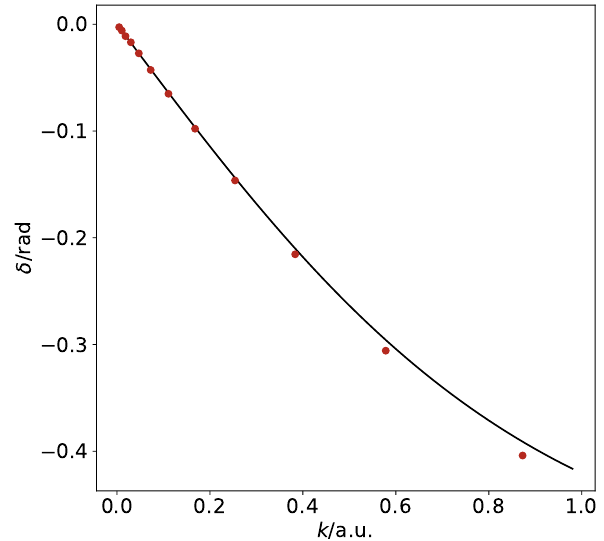
Figure 3. Positron–hydrogen s -wave scattering phase shifts in the static approximation. Red data points: phase shifts obtained using the present variational method. Black line: data obtained by solving the radial Schrödinger equation using the suite of codes described in